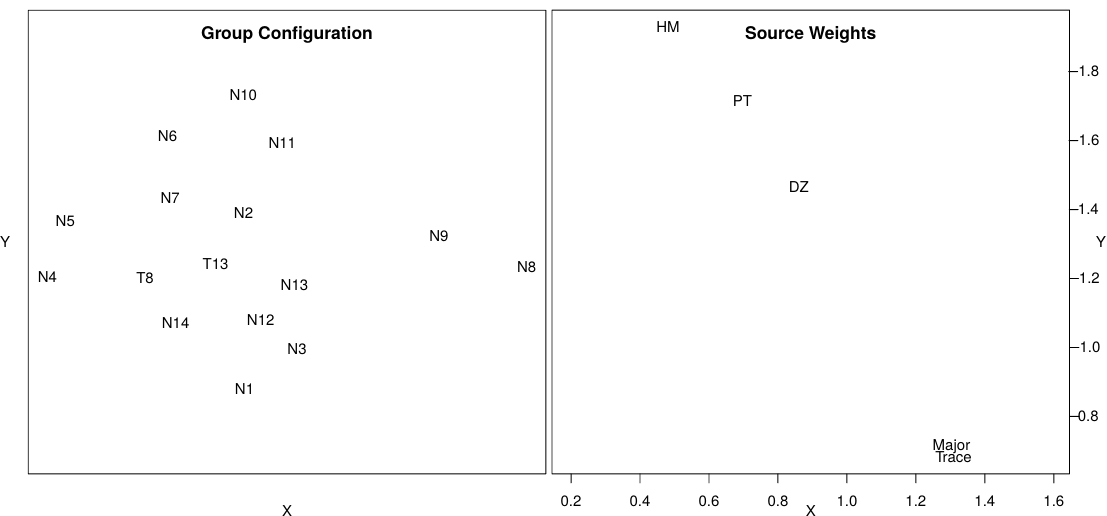
Figure 6. Output of the 3-way MDS analysis of Namib desert sand. Left: the group configurations show the salient similarities and differences between samples as a ‘map’ in which similar samples plot close together and dissimilar samples plot far apart. Right: the weights for each of the five data sources show that provenance proxies that are performed on the bulk sediment (e.g., the major and trace element compositions) attach a stronger weight to the X- than the Y-axis. In contrast, proxies that are determined on specific density fractions (e.g., zircons, heavy minerals, or quartz—feldspar—lithics), attach stronger weight to the Y-axis. One geological interpretation of these dimensions is that samples that horizontally separated from each other on the group configuration (e.g., N4 and N8) have experienced hydraulic sorting, whereas samples that are vertically separated (e.g., N1 and N10) have a different